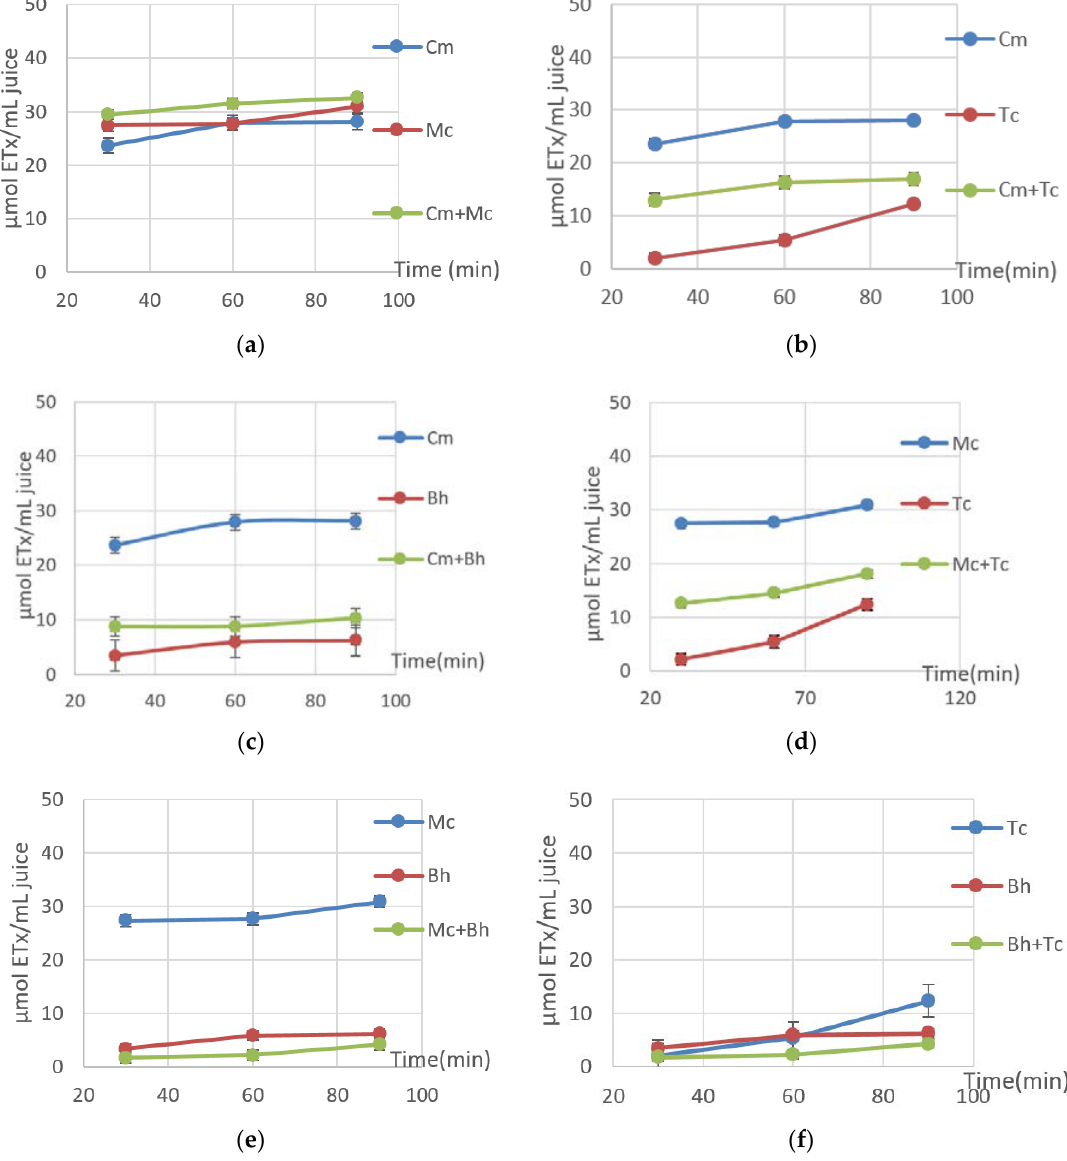
Figure 6. ABTS radical scavenging activity of ( a ) Cm, Mc, Cm + M c, ( b ) Cm, Tc, Cm + T c, ( c ) Cm, Bh, Cm + Bh, ( d ) Mc, Tc, Mc + T c, ( e ) Mc, Bh, M c + Bh, ( f ) Tc, Bh, Bh + T c; where Cm- C. metuliferus , Tc - T. cucumerina , Mc - M. charantia, Bh- B. hispida.